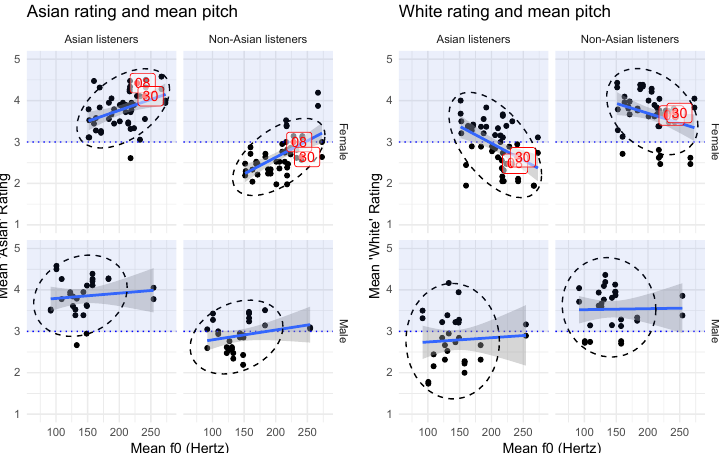
Figure 10. Among both Asian and non-Asian listeners, a higher pitch (fundamental frequency, or f0) correlated with perceived Asianness for female speakers, but not for male speakers. Two speakers with high Asian ratings and relatively high-pitched voices are labeled and discussed in Section